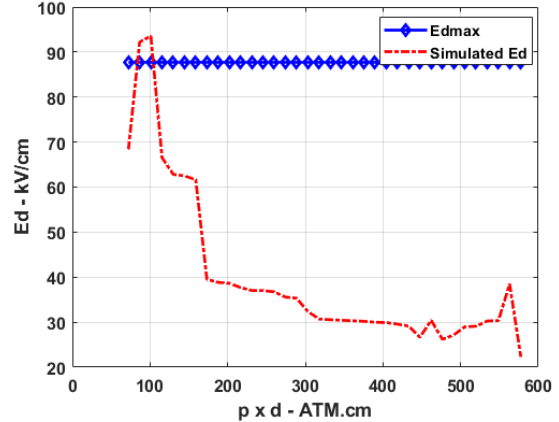
Figure 10. The simulated electric field of SF6 GIT for selected point.